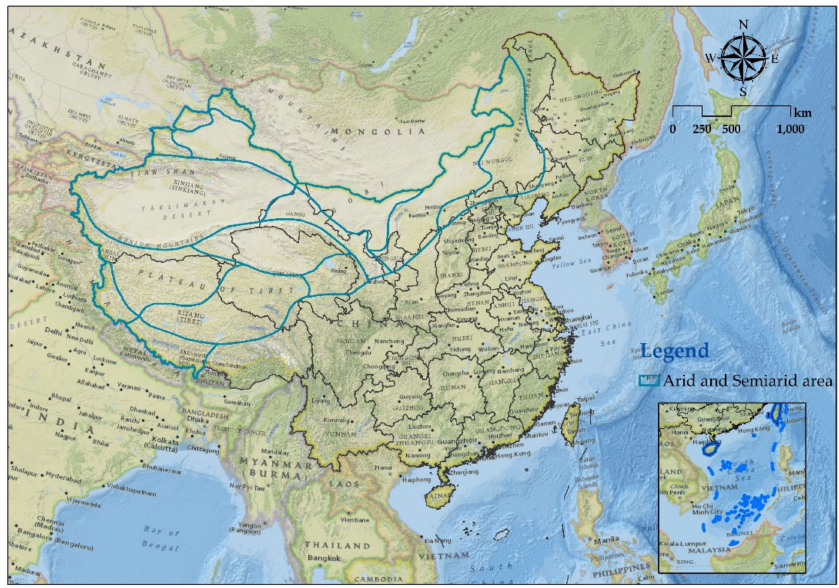
Figure 1. The physical location of the study